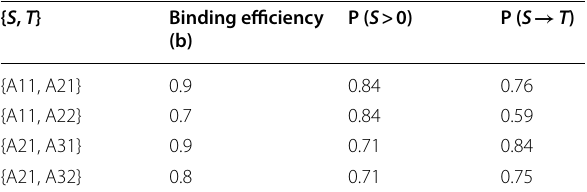
Table 1 The binding efficiency (b) of the source gene (S) on the promoter region of the target gene (T), the probability that the expression level of the source gene is greater than 0, P(S > 0), and the probability that the expression levels of the target gene are actually determined by the expression levels of the source gene, P (S T), in the simulated network with 6 nodes (Fig. 3a) → { S , T } Binding efficiency